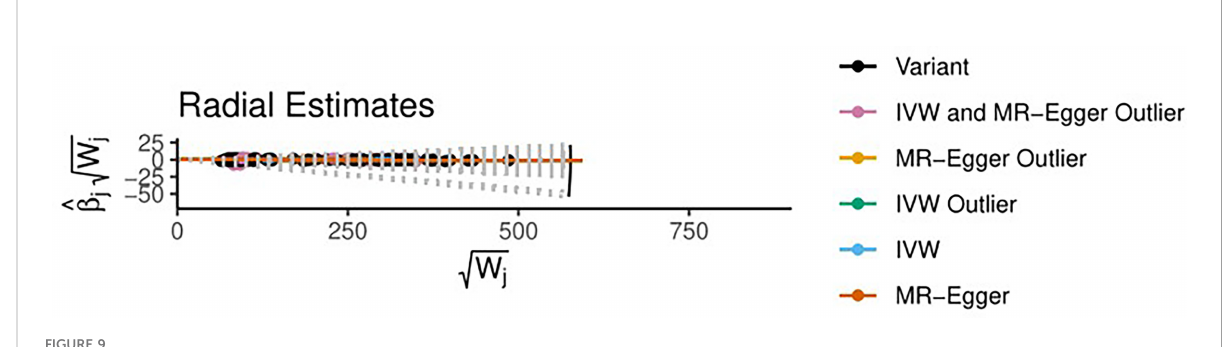
FIGURE 9 Diagram of the radial estimates (TN ! BN).